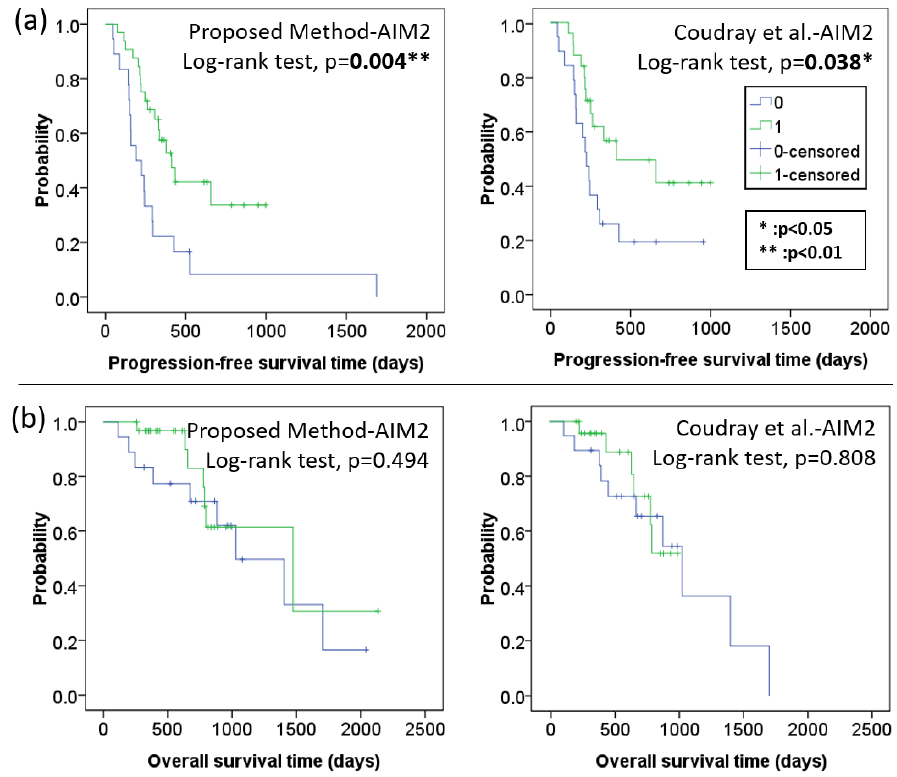
Figure 6. ( a ) Kaplan–Meier PFS and; ( b ) OS analysis for EOC and PSPC patients receiving beva- cizumab therapy based on AI prediction outcomes (0: invalid; 1: effective) by the two best models, i.e., proposed method-AIM2 and Coudray et al. [44]-AIM2. Table 5. Multivariate analyses of DL model prediction and clinical factors associated with